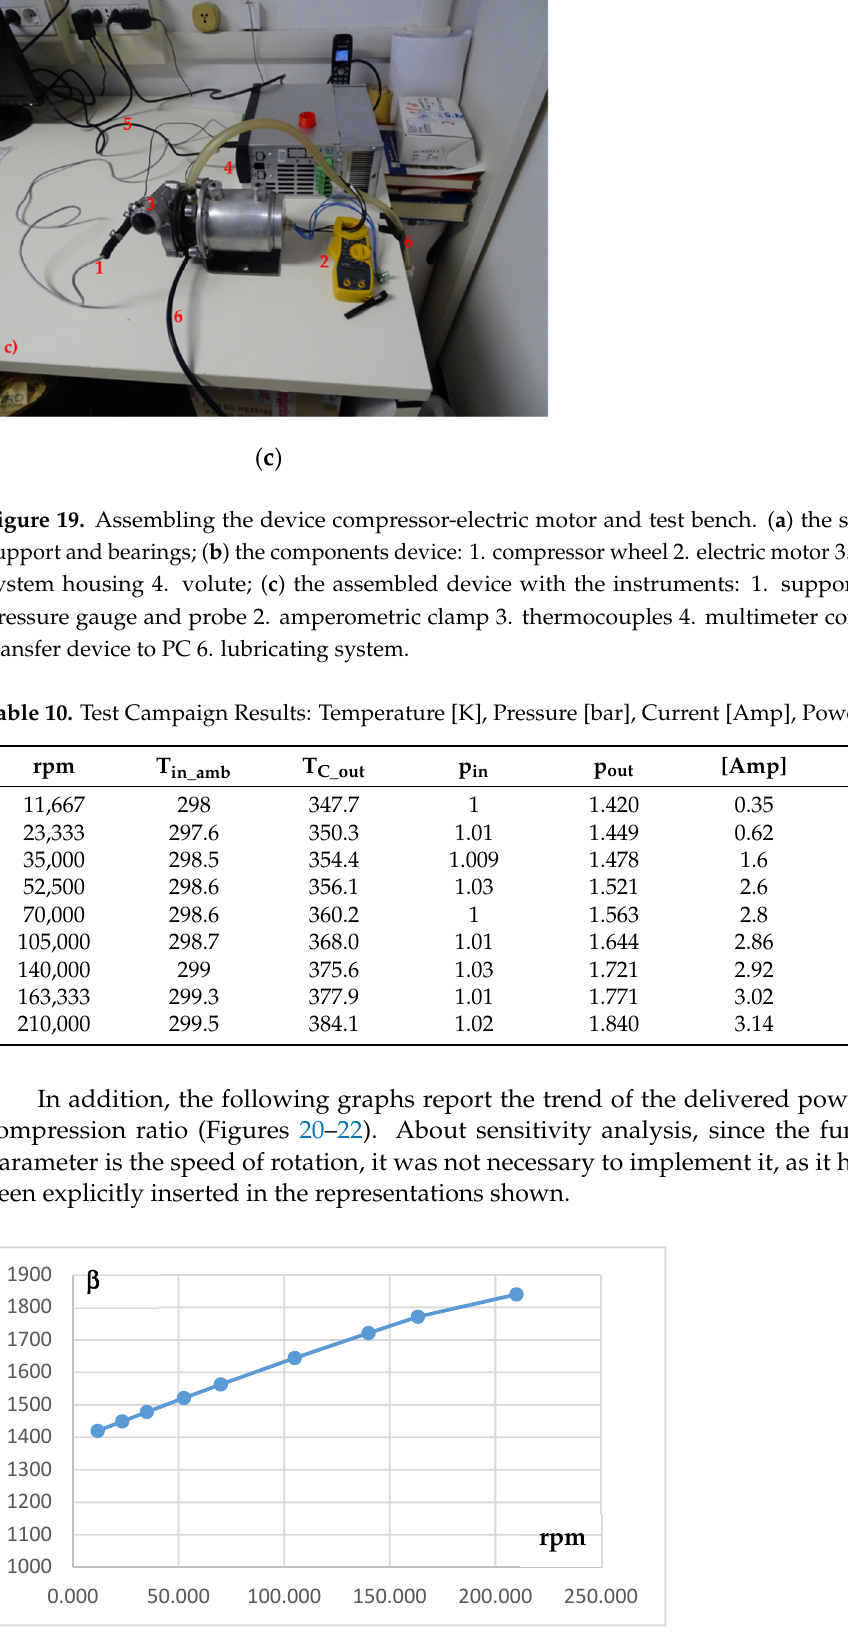
Figure 20. Compression ratio in function of the EM rpm.